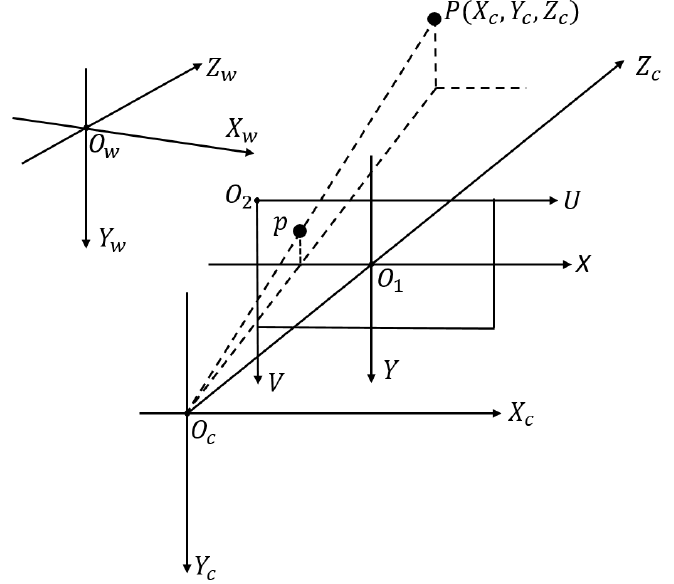
Figure 3. A pinhole system utilized for modeling a camera of the robot binocular vision system. It consists of four coordinate systems, wherein O c and Z c denote the optical center and optical axis of the camera,